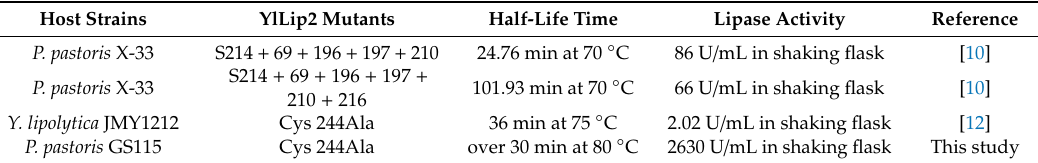
Figure 6. Wet cell weight, lipase activity, total protein concentration, and OD 600 during high-density fermentation of recombinant strain GS115 / 2lip2-hac1-vgb #21 in a 3 L fermenter. Data are the mean ± standard deviation of triplicate experiments. Table 2. Comparison of the YlLip2 mutant expression levels in Pichia pastoris